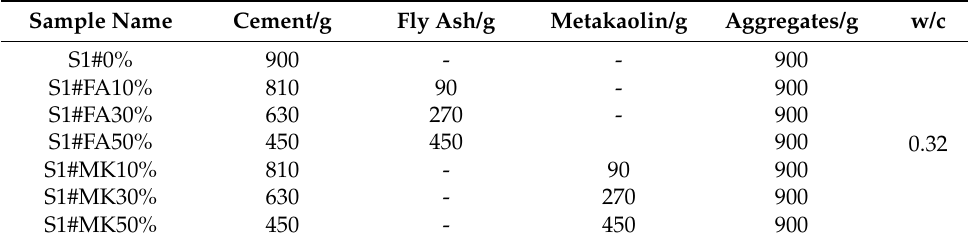
Table 3. Mix design of concrete